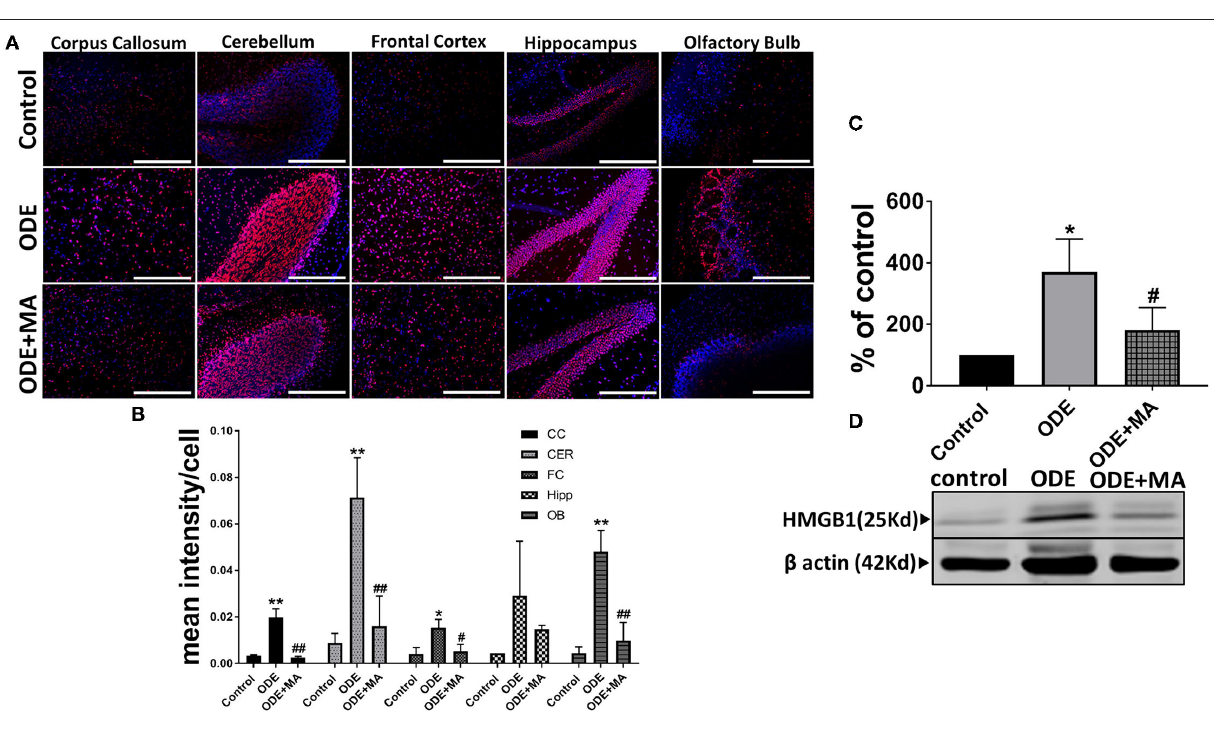
FIGURE 2 | ODE induces HMGB1 expression in various regions of mice brain. Paraffin embedded sections from perfused mice brain were stained with anti-HMGB1 (Cy3, red) antibody and nuclei were identified with 4’, 6-Diamidino-2-Phenylindole, Dihydrochloride (DAPI, blue) (A) . HMGB1 expression in immunohistochemistry (IHC) was quantified by a blinded investigator. Compared to control, ODE-exposed mice showed higher amounts of HMGB1 staining in the corpus callosum, cerebellum, frontal cortex, and olfactory bulb of the brain. MA (C11) treatment significantly reduced HMGB1 expression (B) . Whole cell lysate from freshly dissected mice brain were processed for western blot analysis. HMGB1 and β -actin antibodies (house-keeping protein) detected 25 and 42 kD bands, respectively. Densitometry of normalized bands showed that, compared to controls, ODE exposure increased the HMGB1 protein level in mice brain and that MA treatment significantly reduced HMGB1 protein levels (C,D) ( n = 5, *exposure effect, ** indicates a significant change with respect to control, # MA treatment effect, ## indicates significant change with respect to MA (mitoapocynin). p < 0.05, micrometer bar = 50 µ m).